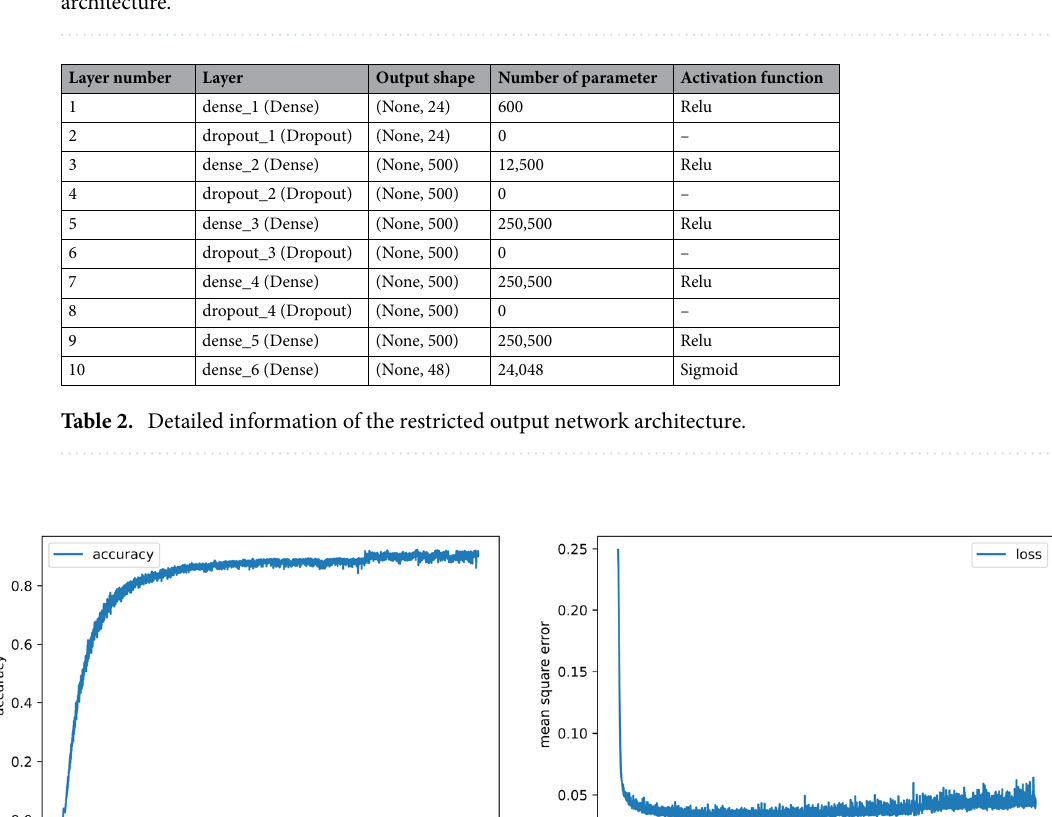
Figure 4. Curves of ( a ) accuracy and, ( b ) loss function relative to 10,000 Epochs for non-restricted network architecture.